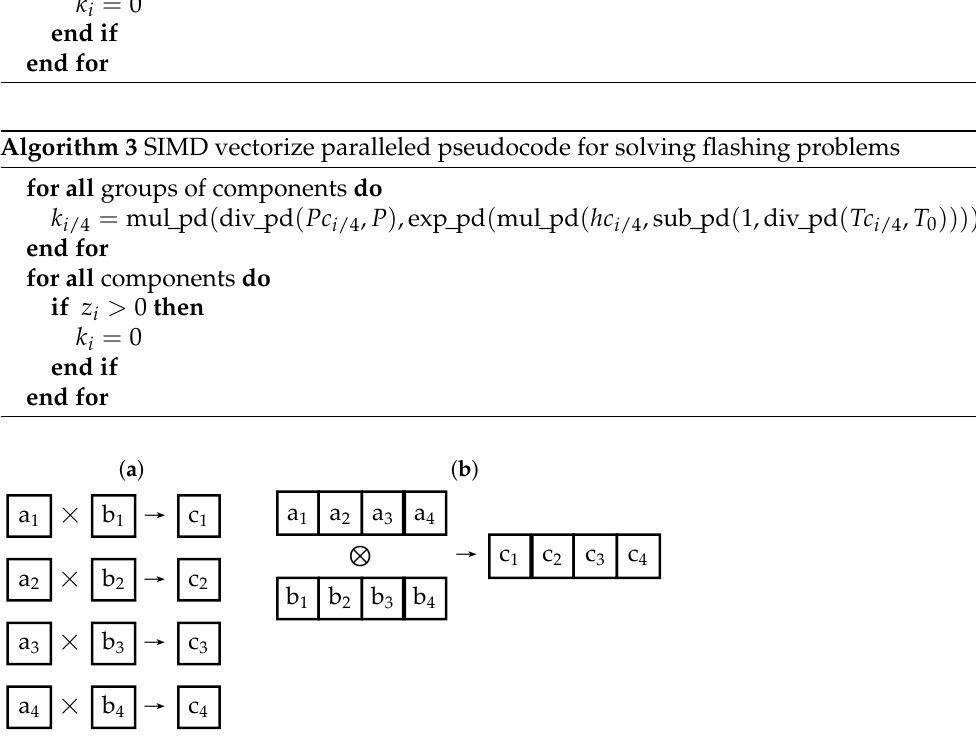
Figure 11. Difference between operation with normal instruction and SIMD instruction. ( a ) Normal instruction. ( b ) SIMD